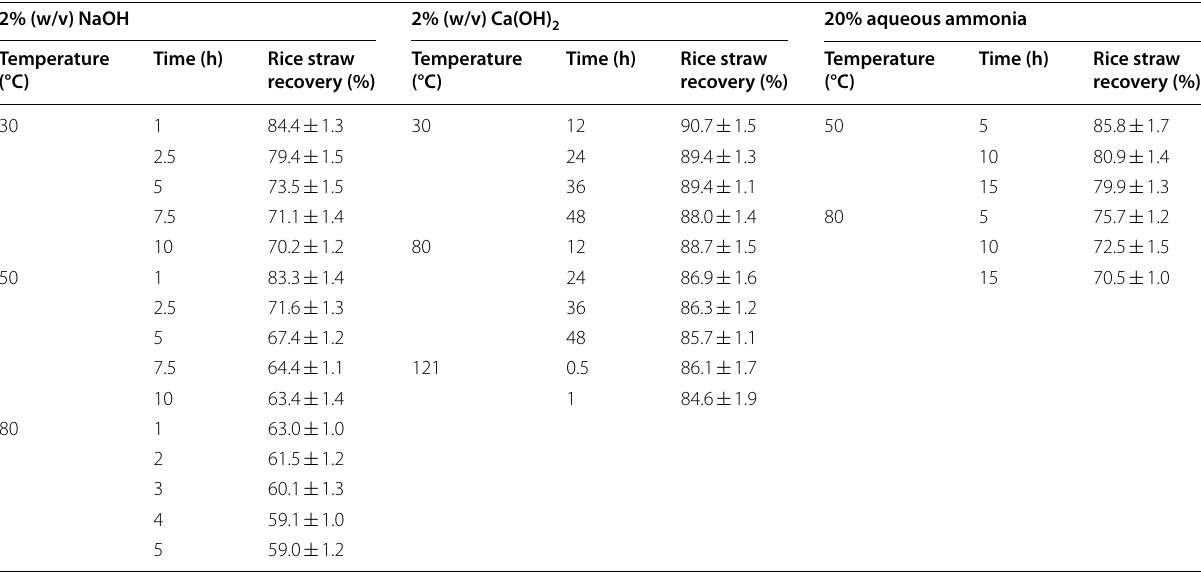
Table 1 Rice straw recovery after pretreatment with alkali at different incubation temperatures and times 2% (w/v) NaOH 2% (w/v) Ca(OH) 2 20% aqueous ammonia Temperature Time (h) Rice straw Temperature Time (°C) recovery (%) (°C)